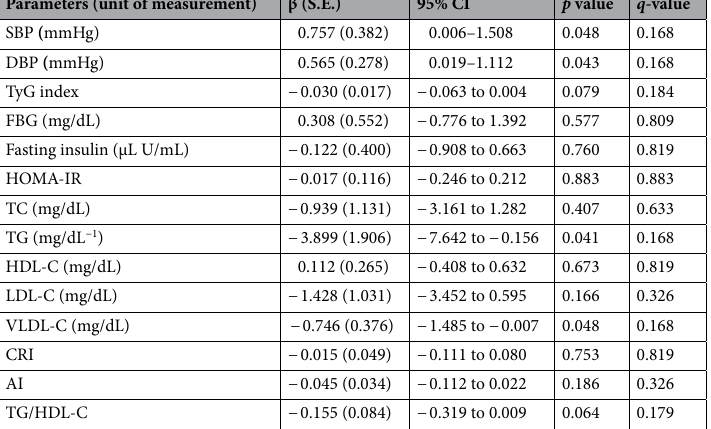
Table 5. Association of the genetic risk score with obesity-related metabolic traits. SBP systolic blood pressure, DBP diastolic blood pressure, TyG the product of triglycerides and glucose, FBG fasting blood glucose, HOMA-IR homeostatic model assessment-insulin resistance, TC total cholesterol, TG triglyceride, HDL-C high-density lipoprotein cholesterol, LDL-C low-density lipoprotein cholesterol, VLDL-C very-low-density- lipoprotein cholesterol, CRI Coronary Risk Index, AI Atherogenic Index, TG/HDL-C triglyceride-to-HDL-C ratio, SE standard error, CI confidence interval, q-value corrected p value. The association of the genetic risk score with metabolic traits was determined by linear regression. Effect size (β) and 95% confidence intervals were computed to seek rise or fall in the selected parameter per each risk allele increase. All association analyses were adjusted for age and gender and corrected for multiple comparisons via the Benjamini– Hochberg method. A p value < 0.05 was considered statistically